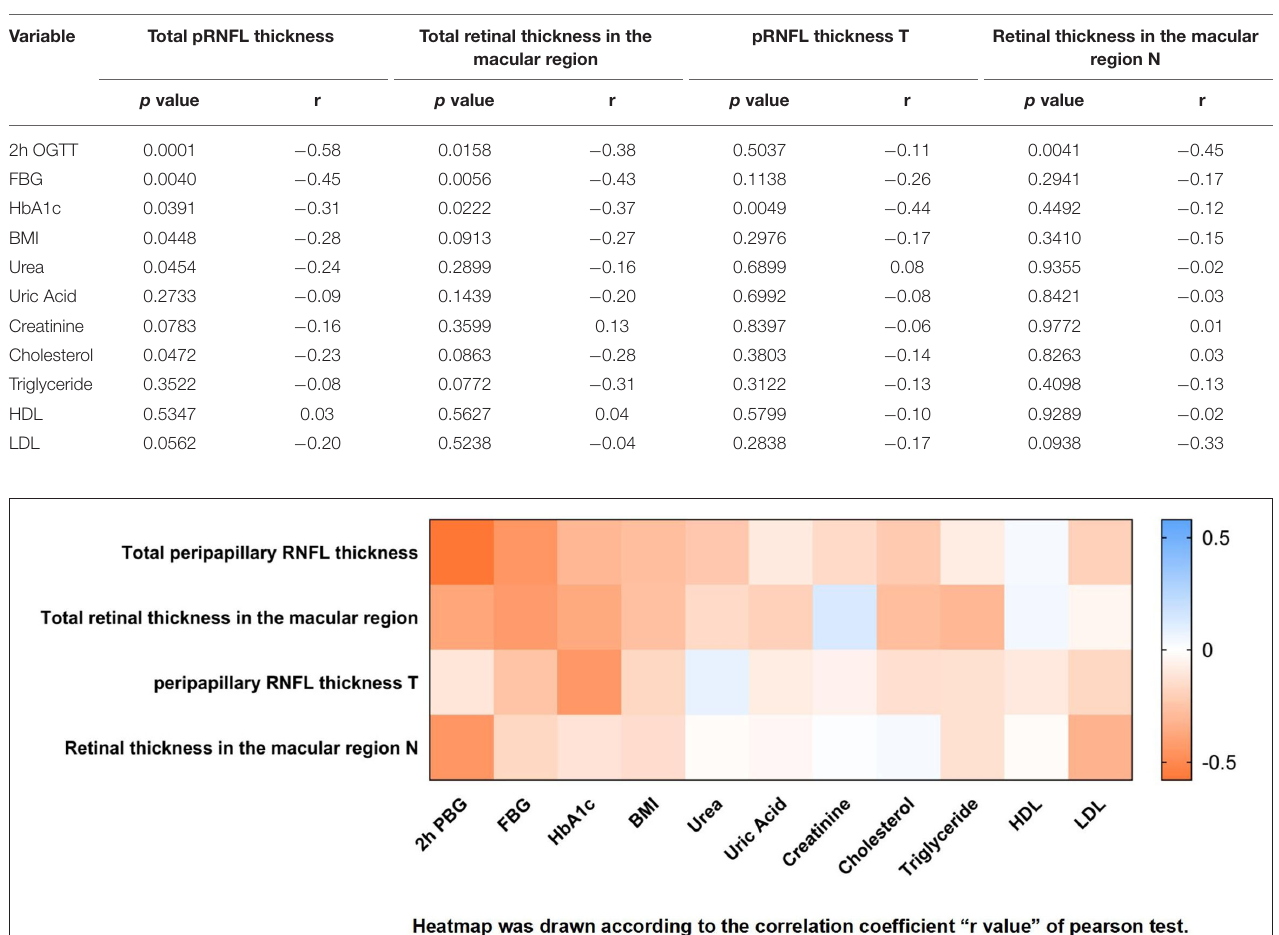
TABLE 3 | Pearson correlation analysis of pRNFL and retina in the macular region influence factors. Variable